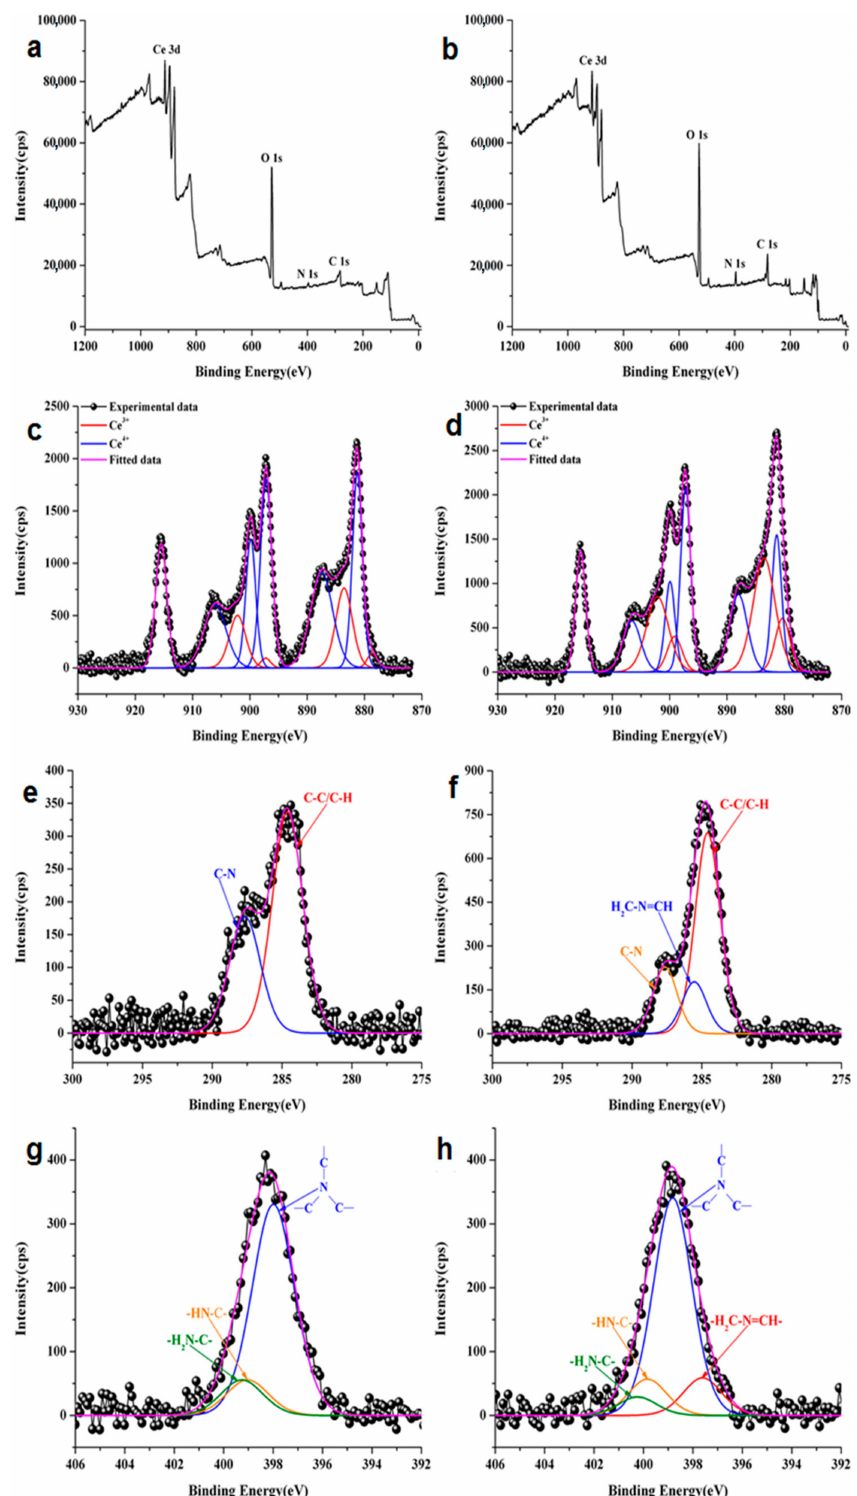
Figure 4. X-ray photoelectron spectroscopy (XPS) wide scan spectra for ( a ) CePEI, ( b ) CePEI-GA. Deconvoluted XPS spectra for CePEI (left) and CePEI-GA (right) specific for Ce 3d ( c , d ), C 1s ( e , f ), N 1s ( g , h